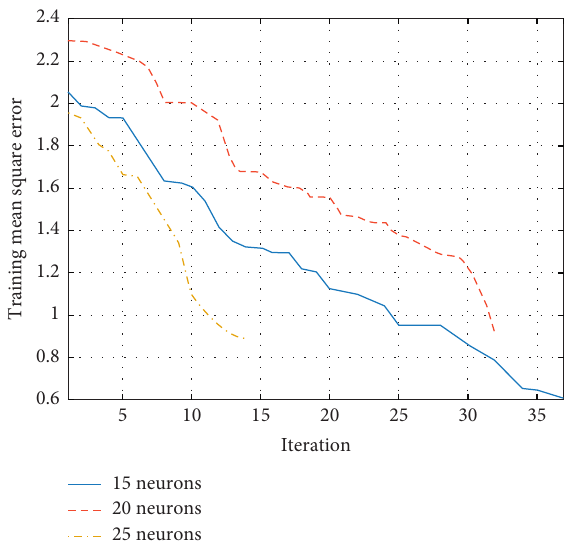
Figure 9: ANN training results for RPR arm with assuming 15, 20, and 25 neurons in the hidden